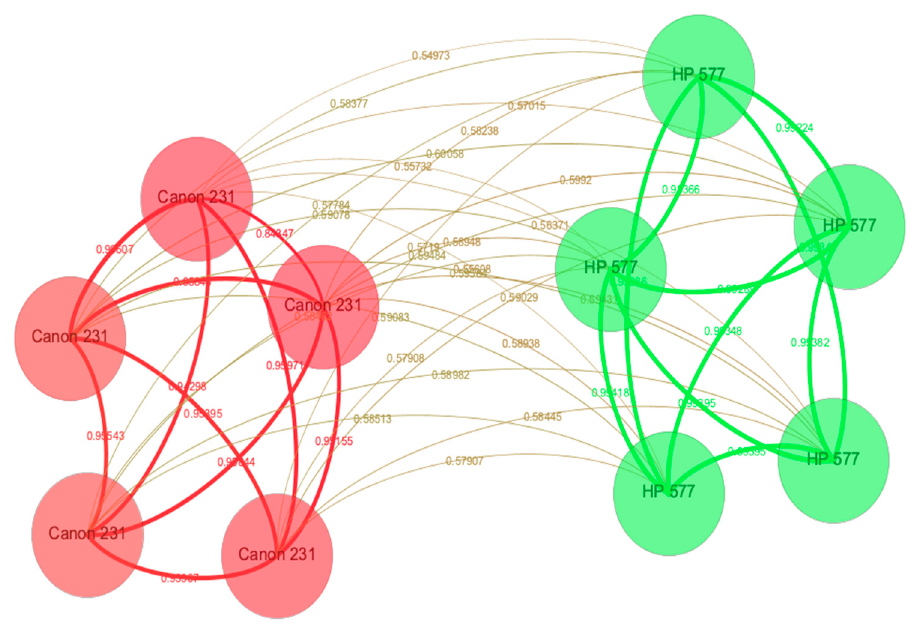
Figure 5. Test 1, distinguishing documents of two different printers; Laser and Inkjet using the algorithm proposed in [35].